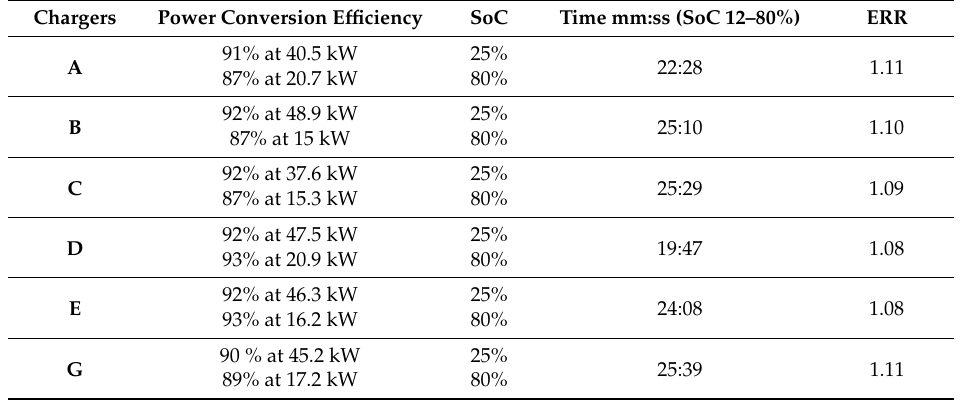
Table 5. Power conversion efficiency and delivered power at 25% of SoC at 40 °C, − 15 °C, and − 25 °C.